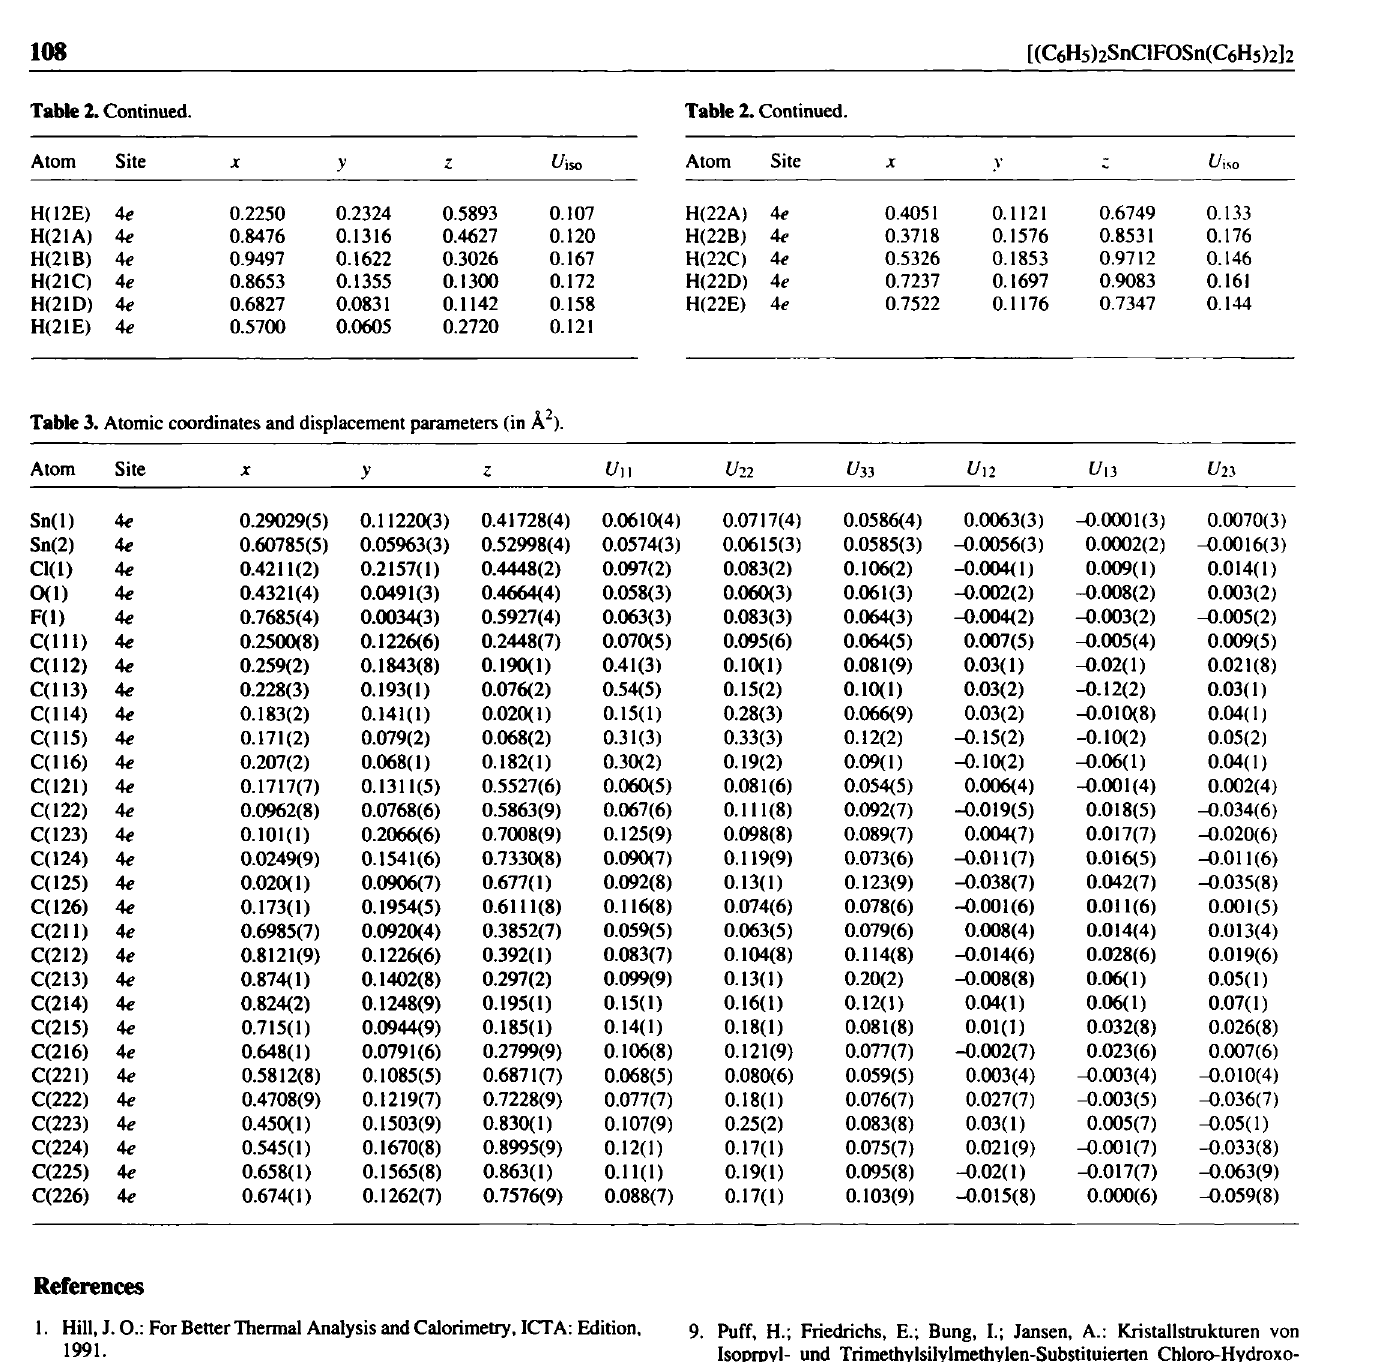
Table 3. Atomic coordinates and displacement parameters (in Â 2